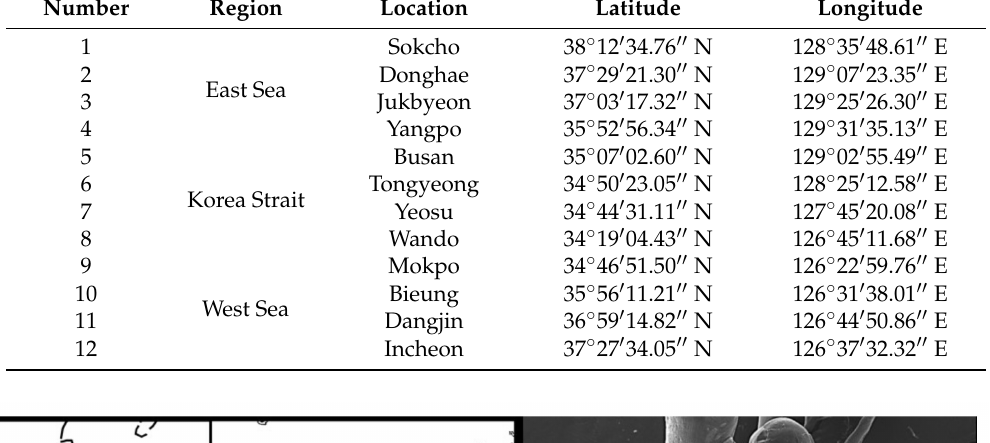
Table 1. Geological coordinates of seawater sampling sites in the field survey.